Question: What form of chart is displayed?
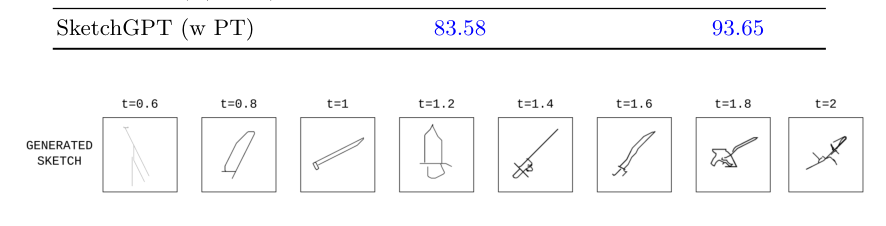
Answer: line